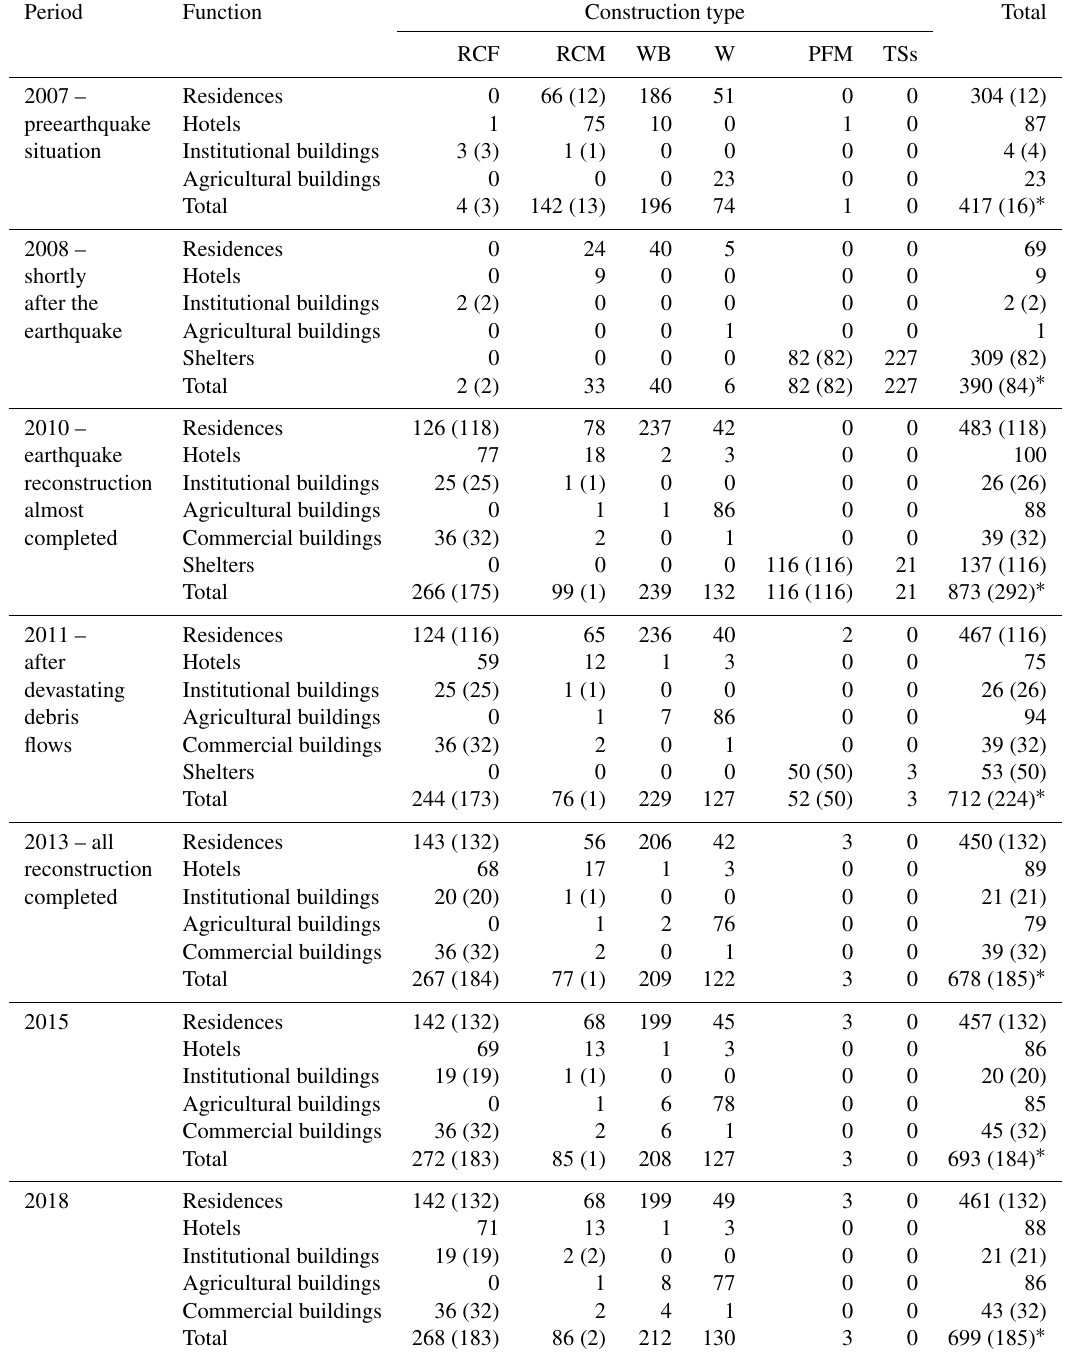
Table 3. Number of functioning buildings per function and construction type for the seven time periods considered. Where applicable, the numbers before the parentheses indicate the total number, and the numbers in the parentheses indicate the building numbers built by the government. ∗ Sum of all